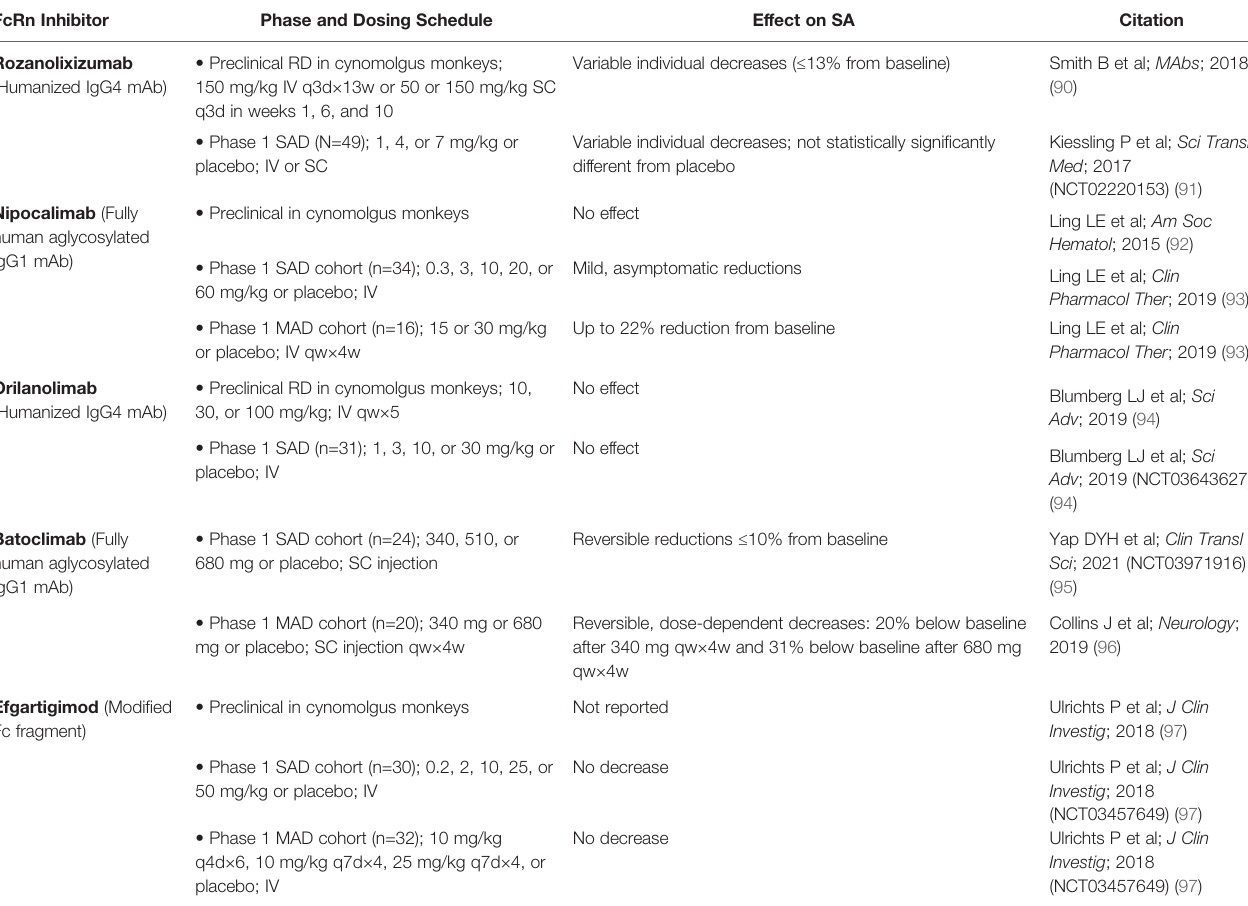
TABLE 2 | Effect of FcRn inhibitors on serum albumin concentration in preclinical and phase 1 studies. FcRn